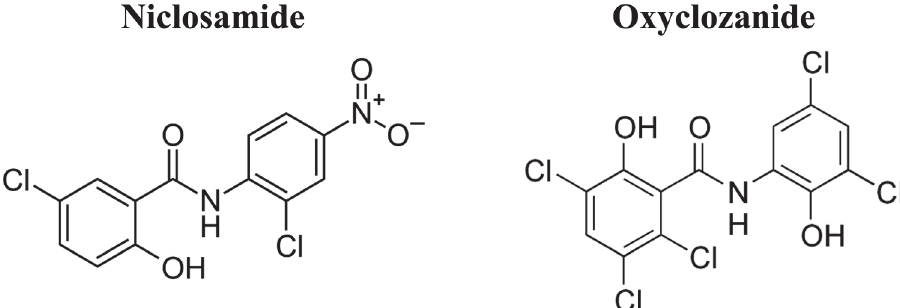
Fig 1. Chemical structure of the salicylanilide anthelmintic drugs niclosamide and oxyclozanide.